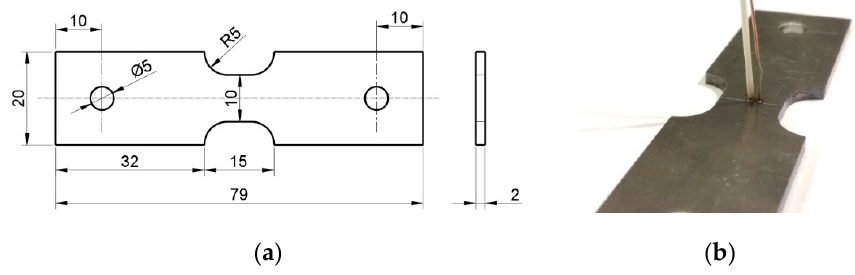
Figure 6. Samples for testing on a Gleeble 3500 device and a tensile test after simulation: ( a ) dimensions of the test sample (unit: mm); ( b ) view of the test sample with a thermocouple welded on it.